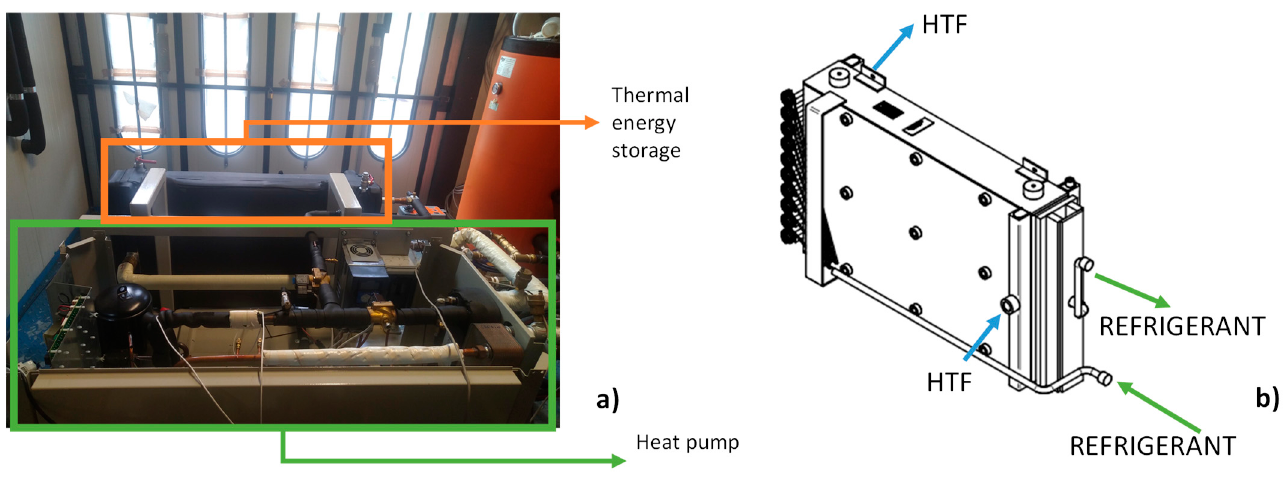
Figure 3. ( a ) heat pump and latent heat storage system installed in the lab during the testing campaign. ( b ) schematic representation of the three-fluid heat exchanger.